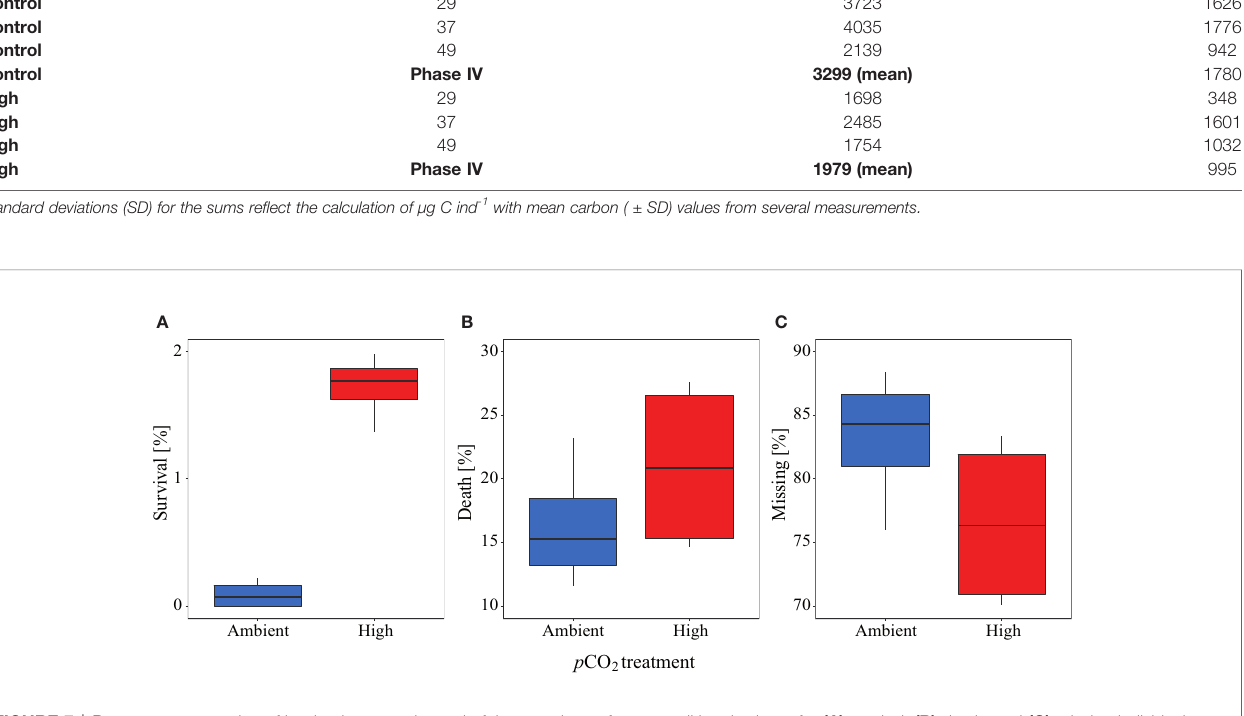
FIGURE 7 | Percentage proportion of herring larvae at the end of the experiment from overall hatched egg for (A) survival, (B) death, and (C) missing individuals. Blue color represents the control, red the high p CO 2 treatment. All boxplots display the mean and the 95% con fi dence interval of the given